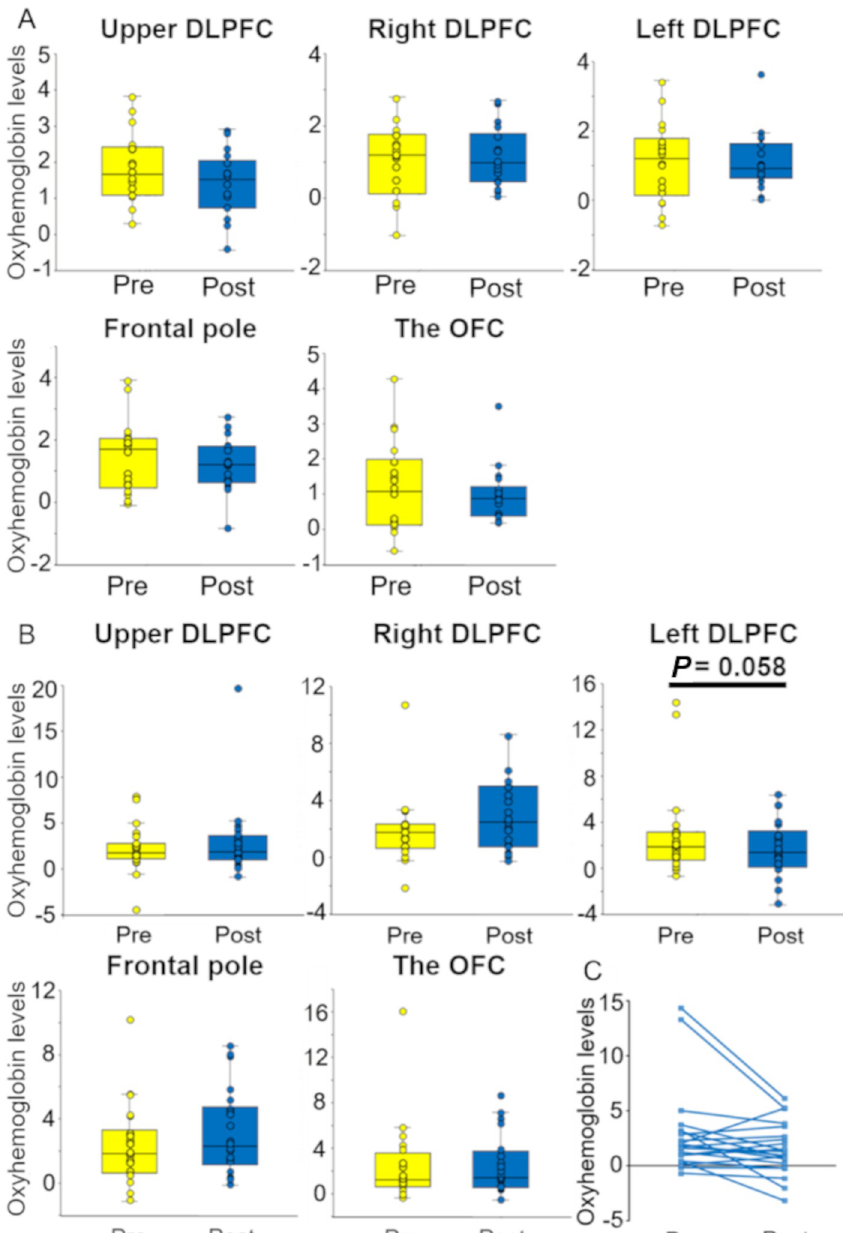
Fig 5. Changes in oxyhemoglobin levels normalized with Z-score before (Pre) and after (Post) pain treatment. A . Participants without pain (no-Pain group, n = 18). No significant difference was found by Wilcoxon signed-rank test ( P = 0.325). The DLPFC comprised the upper region, right region, left region, and frontal pole. The directions of posture were not given to the participants in no-Pain group. That is, only the effects of patch adhesion were examined before (Pre) and after (Post) patch treatment. B . Participants with pain (Pain group, n = 27). In the left DLPFC, there was a tendency of the reduction of oxyhemoglobin levels during patch treatment (n = 21, Wilcoxon signed-rank test, P = 0.058). This reduction was supported by the correlation coefficient ( r = 0.68) calculated for the left DLPFC activity between before patch treatment ( i . e ., Pre) and after patch treatment ( i . e ., Post). The directions of the start and end of posture that produced the pain were given to the participants in Pain group with an audio guide. C . All the data (n = 21) recorded in the left DLPFC of the participants with pain (Pain group) before (Pre) and after (Post) pain